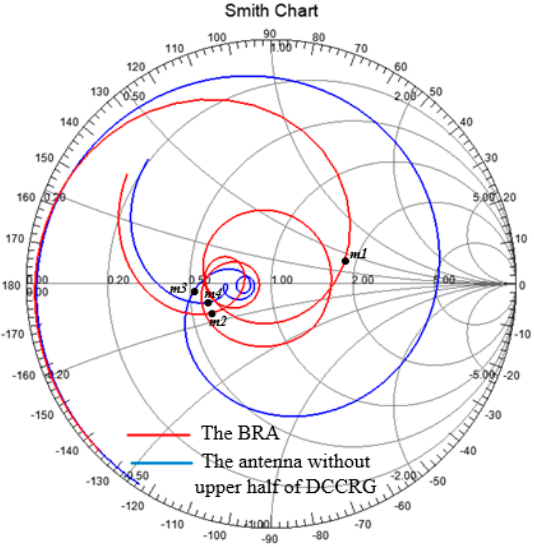
Figure 7. Comparison of input impedance characteristics between the proposed BRA and the antenna without upper half of DCCRG by Smith Chart (marker point: m1, 1.7 GHz; m2, 6.3 GHz; m3, 3.3 GHz; m4, 6.1 GHz).